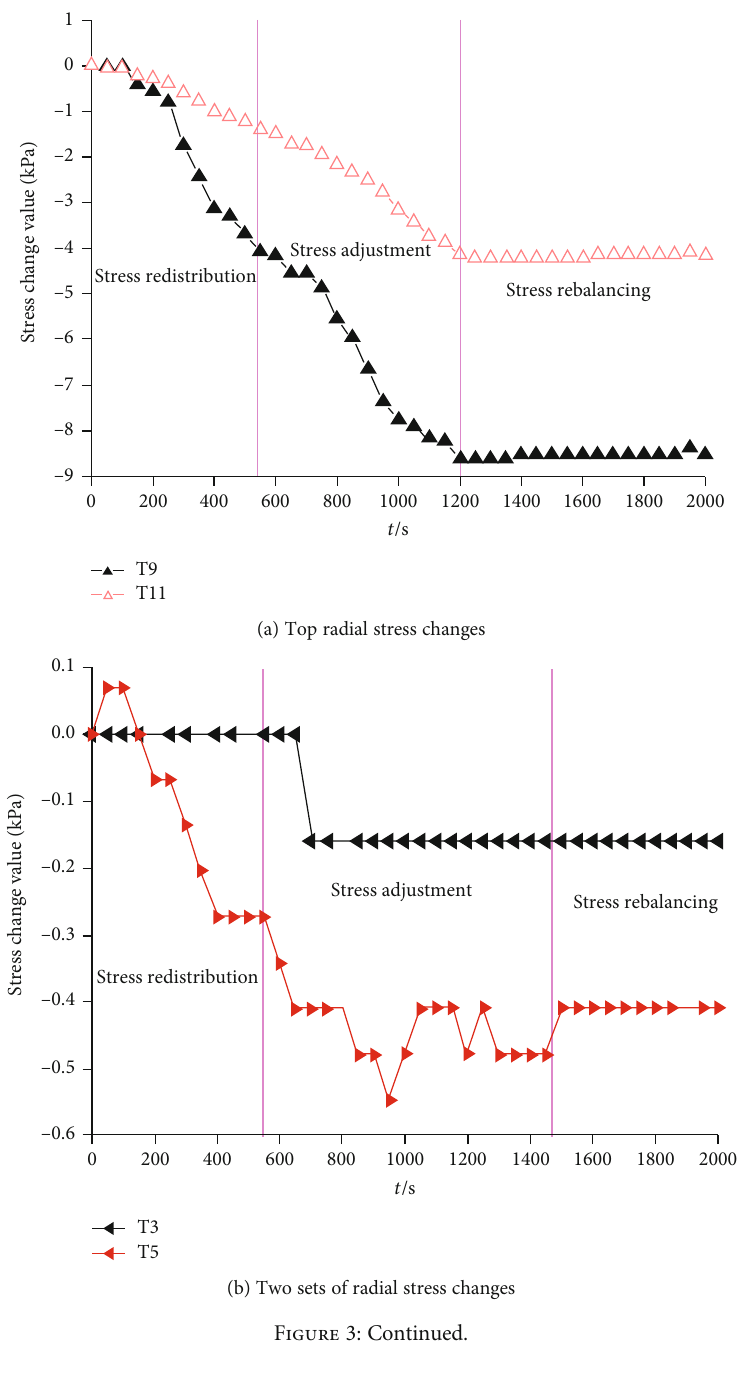
(b) Two sets of radial stress changes Figure 3: